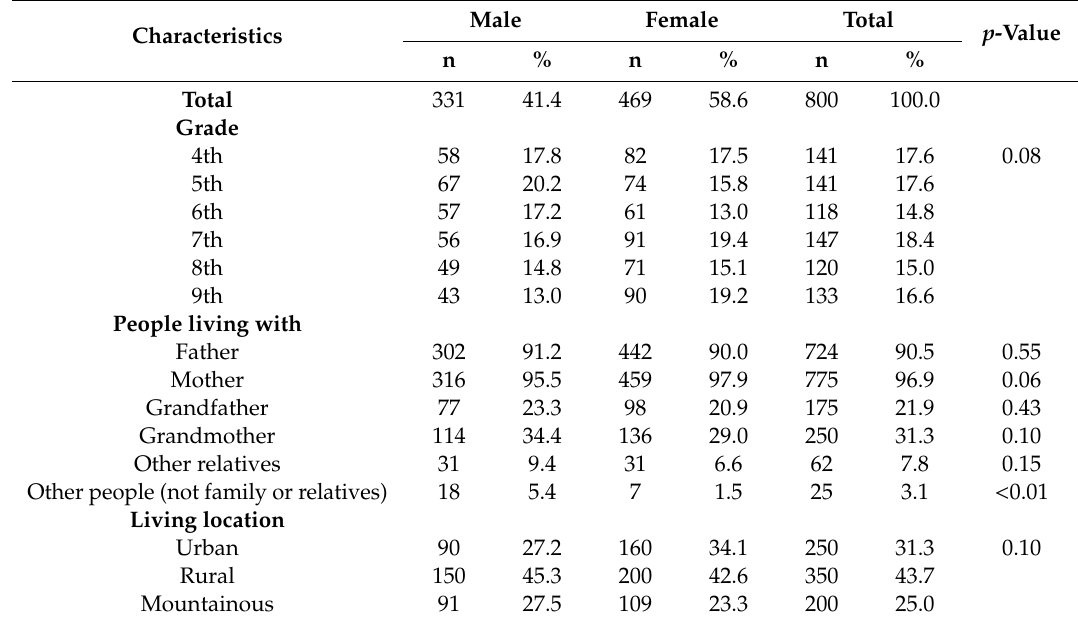
Table 1. Demographic characteristics of the